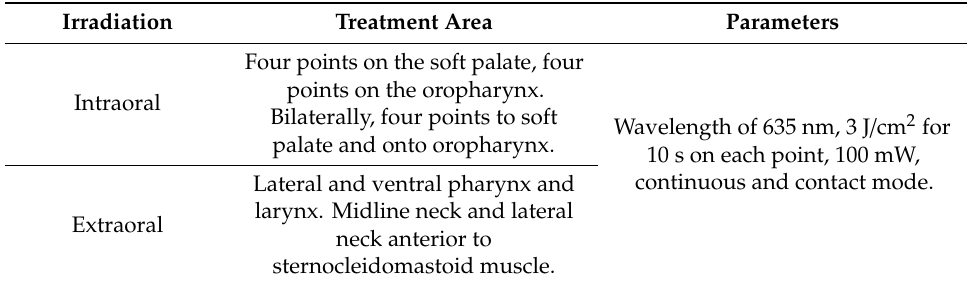
Table 4. Photobiomodulation therapy for the management of dysphagia parameters: Applications and treatment protocol.